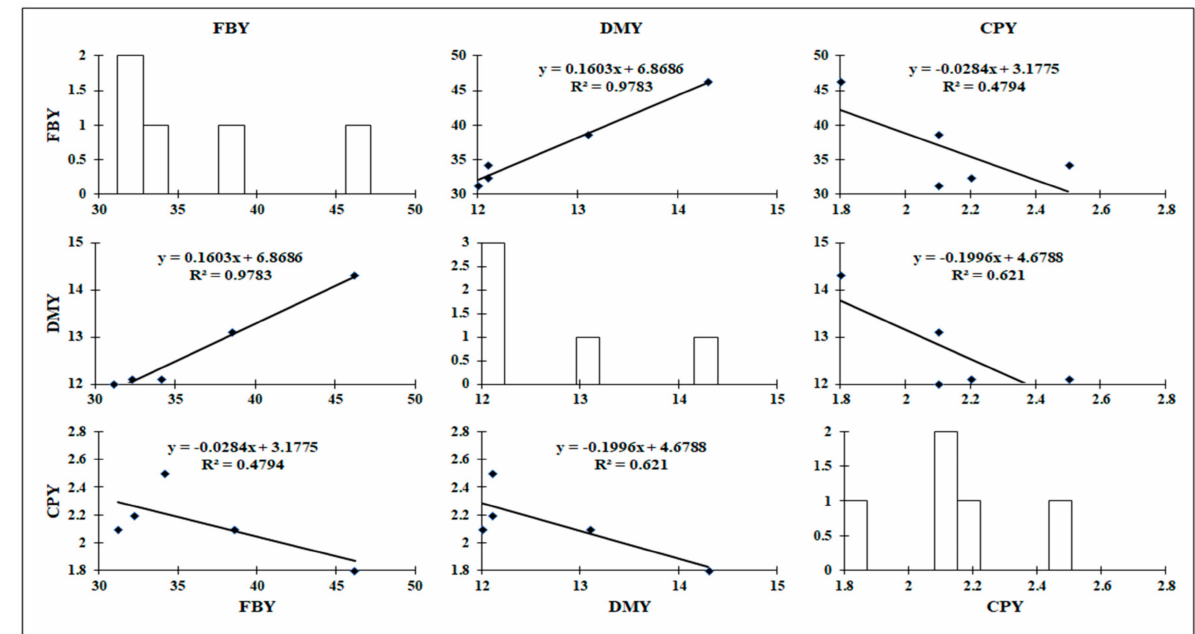
Figure 3. Scatterplot matrix including equation and regression values for pairwise correlation analyses between fresh biomass yield (FBY), dry matter yield (DMY) and crude protein yield (CPY) of maize and intercropped maize-soybean fodders. Diagonal boxes show histograms for each variable. The lower triangular matrix shows the relationship between a pair of